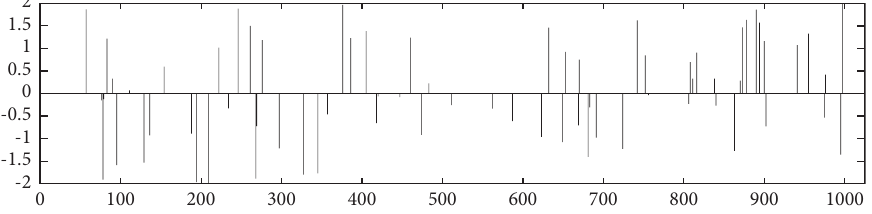
Figure 7: Te original signal contains 70 nonzero components.